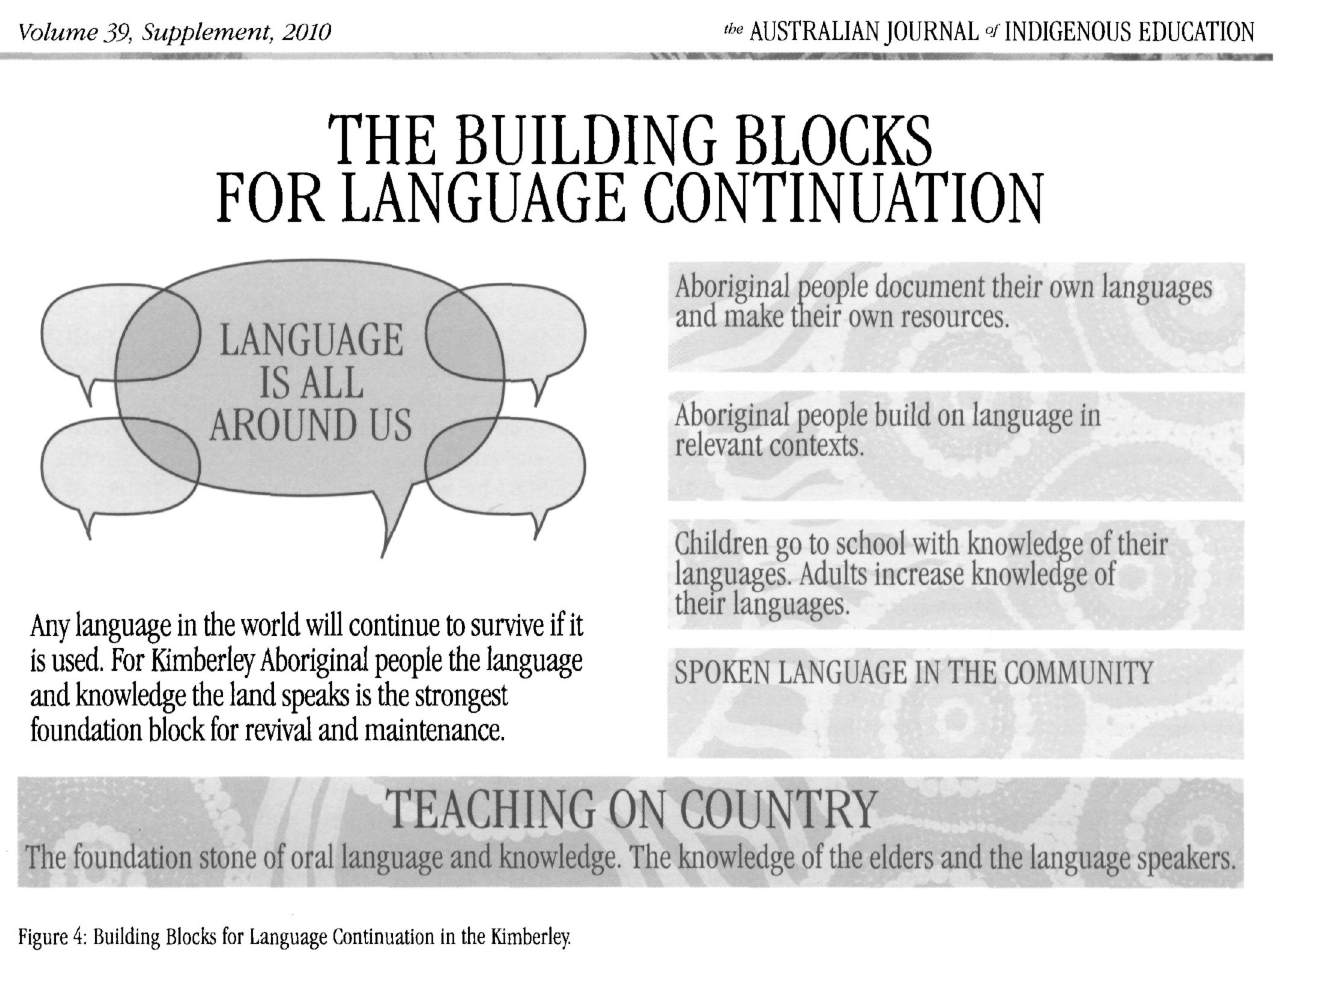
Figure 4: Building Blocks for Language Continuation in the